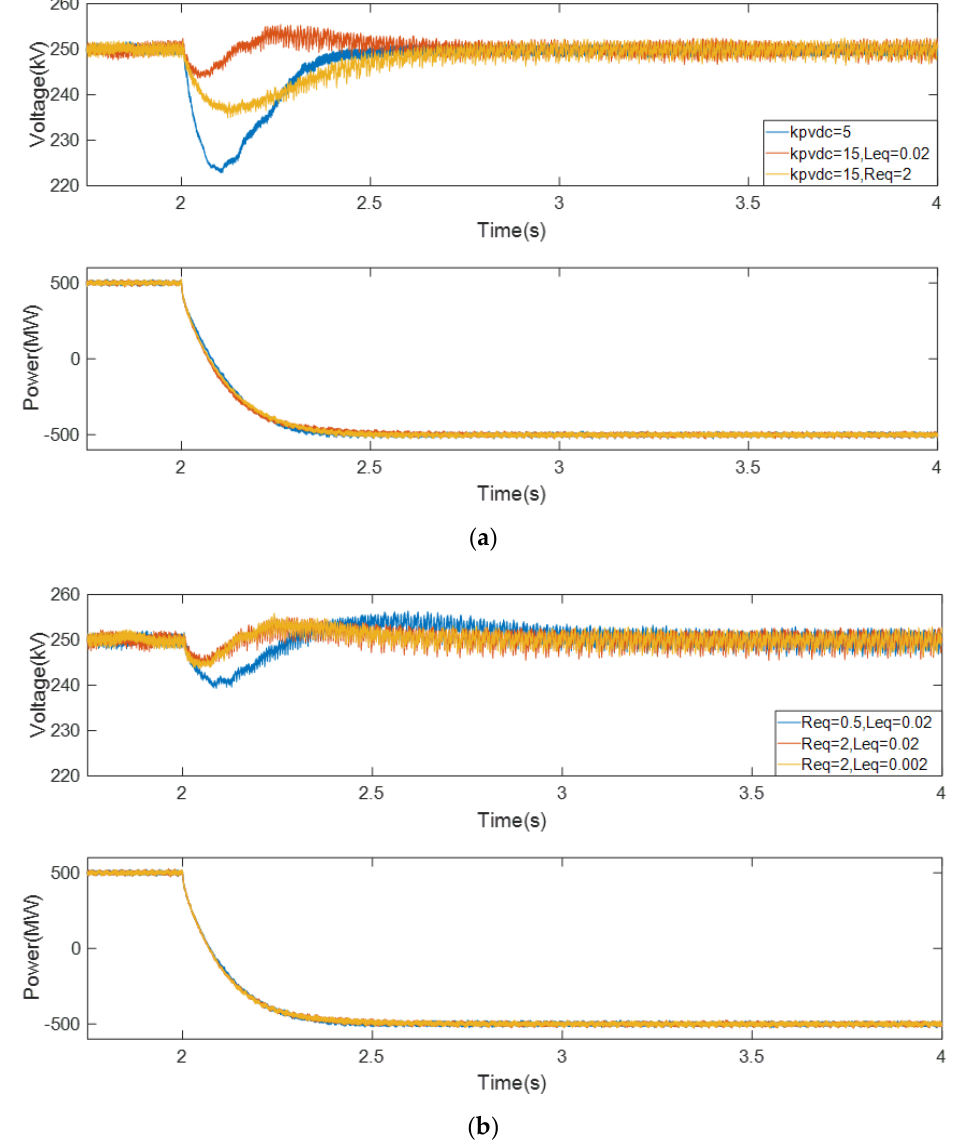
Figure 16. DC-link voltage and active power of the VSC – HVDC system ( a ) under the proposed control strategy and traditional control strategy [13] and ( b ) under the proposed control strategy with different virtual impedance parameters.